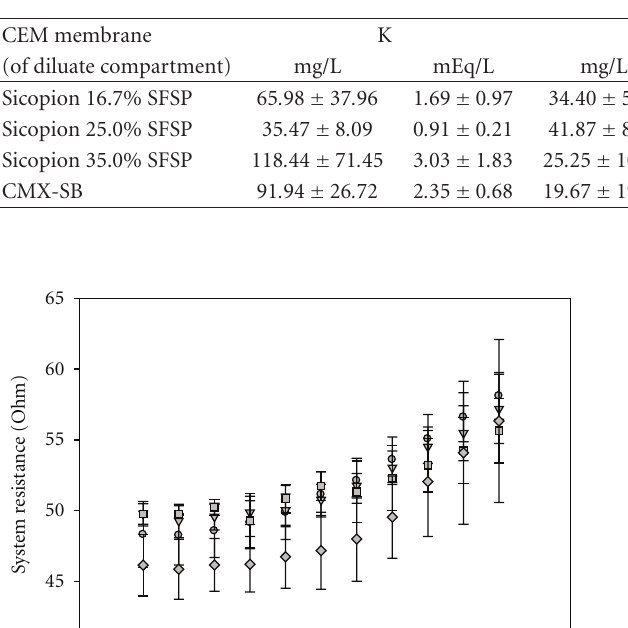
Table 5: Total mineralization rates of the concentrate solution in potassium, calcium, sodium, and total cations after 100-minute treatment, in milligrams per liter (mg/L) and milliequivalents per liter (mEq/L).